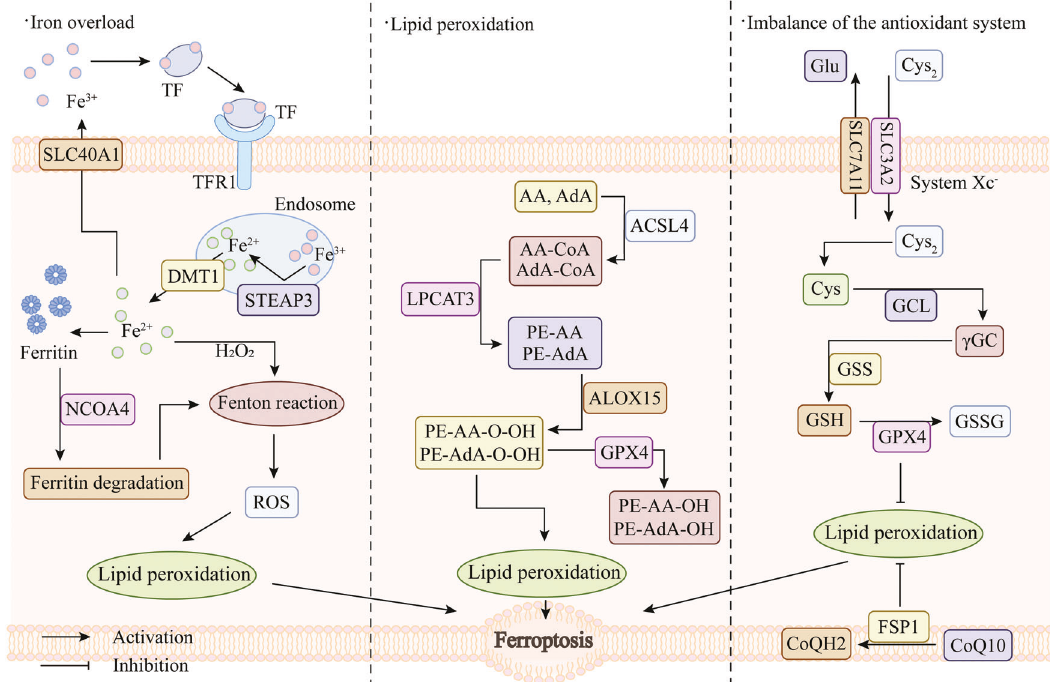
Fig. 1 Core regulatory mechanisms of ferroptosis. TF transferrin, TFR1 transferrin receptor, SLC40A1 solute carrier family 40 member 1, DMT1 solute carrier family 11 member 2, STEAP3 STEAP3 metalloreductase, NCOA4 nuclear receptor coactivator 4, ROS reactive oxygen species, AA arachidonic acid, Ada adrenic acid, CoA coenzyme A, PE phosphoethanolamine, PE-OOH phosphatidylethanolamine hydroperoxide, PE-OH alcohol phospholipid hydroxide, ACLS4 acyl-CoA synthetase long chain family member 4, LPCAT3 lysopho- sphatidylcholine acyltransferase 3, ALOX15 arachidonate 15-lipoxygenase, GPX4 glutathione peroxidase 4, System Xc − cystine/glutamate antiporter system, Cys 2 cystine, Glu glutamate, Cys cysteine, Gly glycine, SLC3A2 solute carrier family 3, member 2, SLC7A11 solute carrier family 7 (L-type amino acid transporter), member 11, GCL glutamate-cysteine ligase, γ GC gamma-glutamylcysteine, GSS glutathione synthetase, GSH glutathione, GSSG oxidized glutathione, CoQ10 coenzyme Q10, FSP1 ferroptosis inhibitor protein 1, CoQH2 ubiquinol.